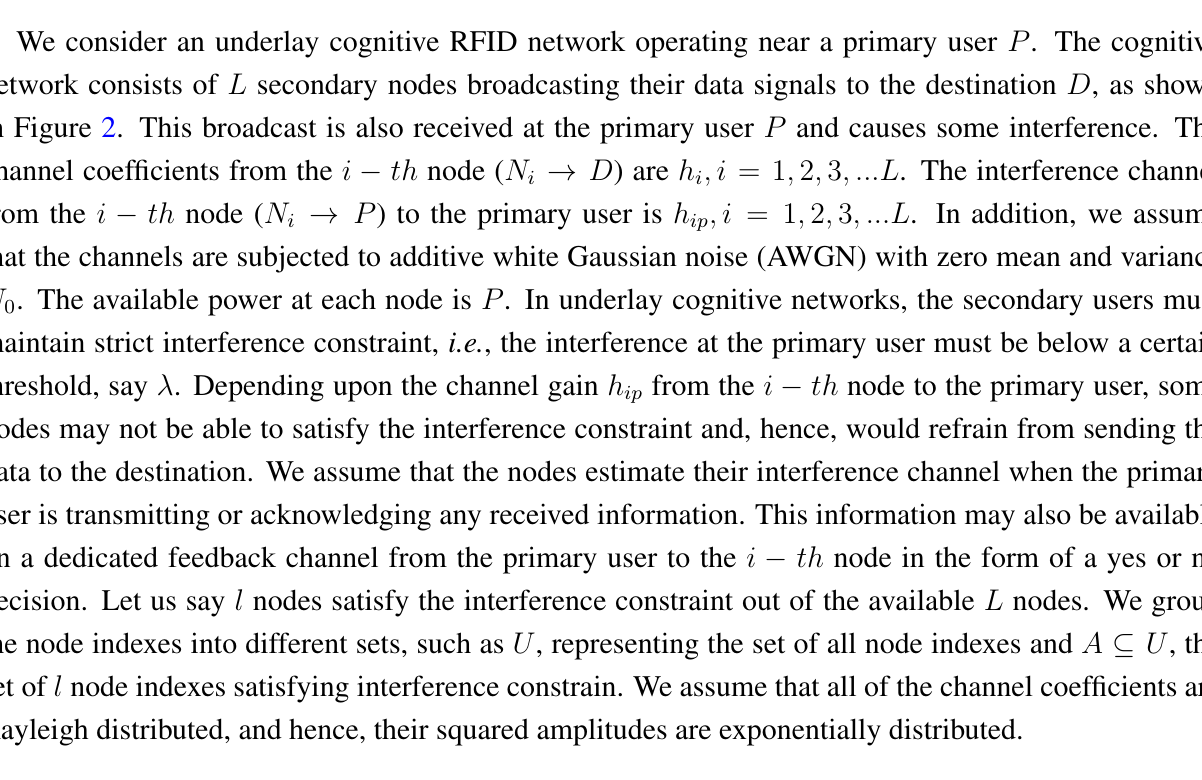
Figure 2. System model: RFID cognitive nodes, the destination node and the primary